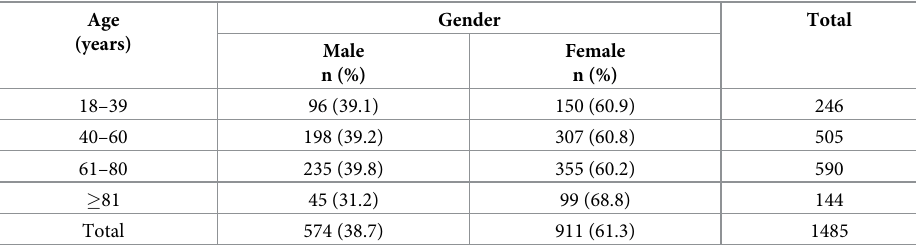
Table 1. Distribution of dermatophytosis according to age and